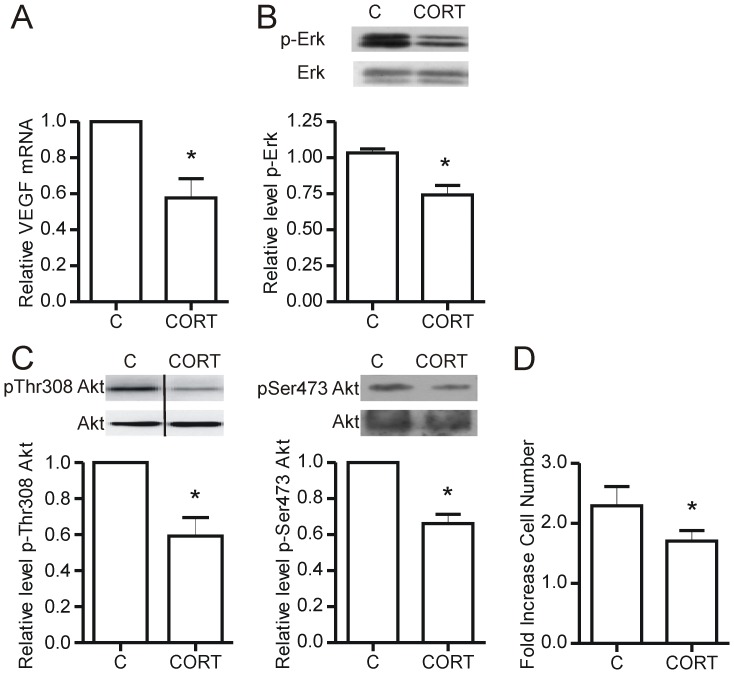
Corticosterone reduces VEGF and inhibits endothelial cell proliferation.Endothelial cells (1.0×106 cells) were plated in 35 mm2 dishes coated with type I collagen and treated with 600 nM corticosterone for 48 hours. Whole cell lysates were used for qRT-PCR or Western blotting. VEGF mRNA levels were decreased with corticosterone treatment (*p = 0.01 vs conrol, n = 6) (A). ERK1/2 (*p = 0.01 vs control, n = 5) (B) and Akt phosphorylation were decreased with corticosterone treatment (pThr308: *p = 0.03 vs control, n = 4; pSer473: *p = 0.003 vs control, n = 5) (C). Representative immunoblots are shown. Endothelial cell proliferation was determined using a CyQuant Cell proliferation kit (Molecular Probes). After 48 hours, endothelial cell proliferation was decreased with corticosterone treatment (*p = 0.02 vs. control, n = 5) (D). C – Control, CORT – Corticosterone. N values represent independent experiments.